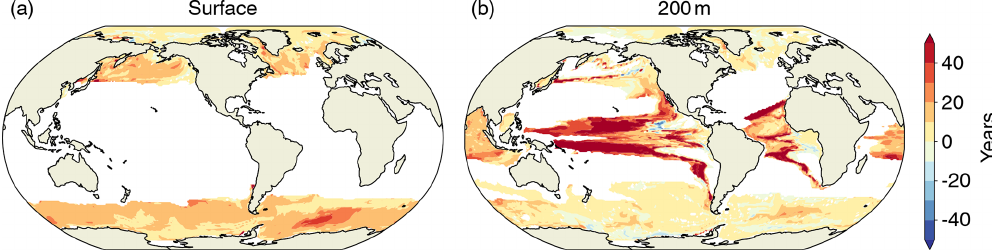
Figure 13. The difference in years between the first occurrence of aragonite undersaturation in the historical and RCP8.5 ensemble and a hypothetical simulation where variability does not change over the 1861–2100 period, but only the mean changes. Positive values (yellow and red) indicate a delayed onset of undersaturation resulting from declines in (cid:127) A